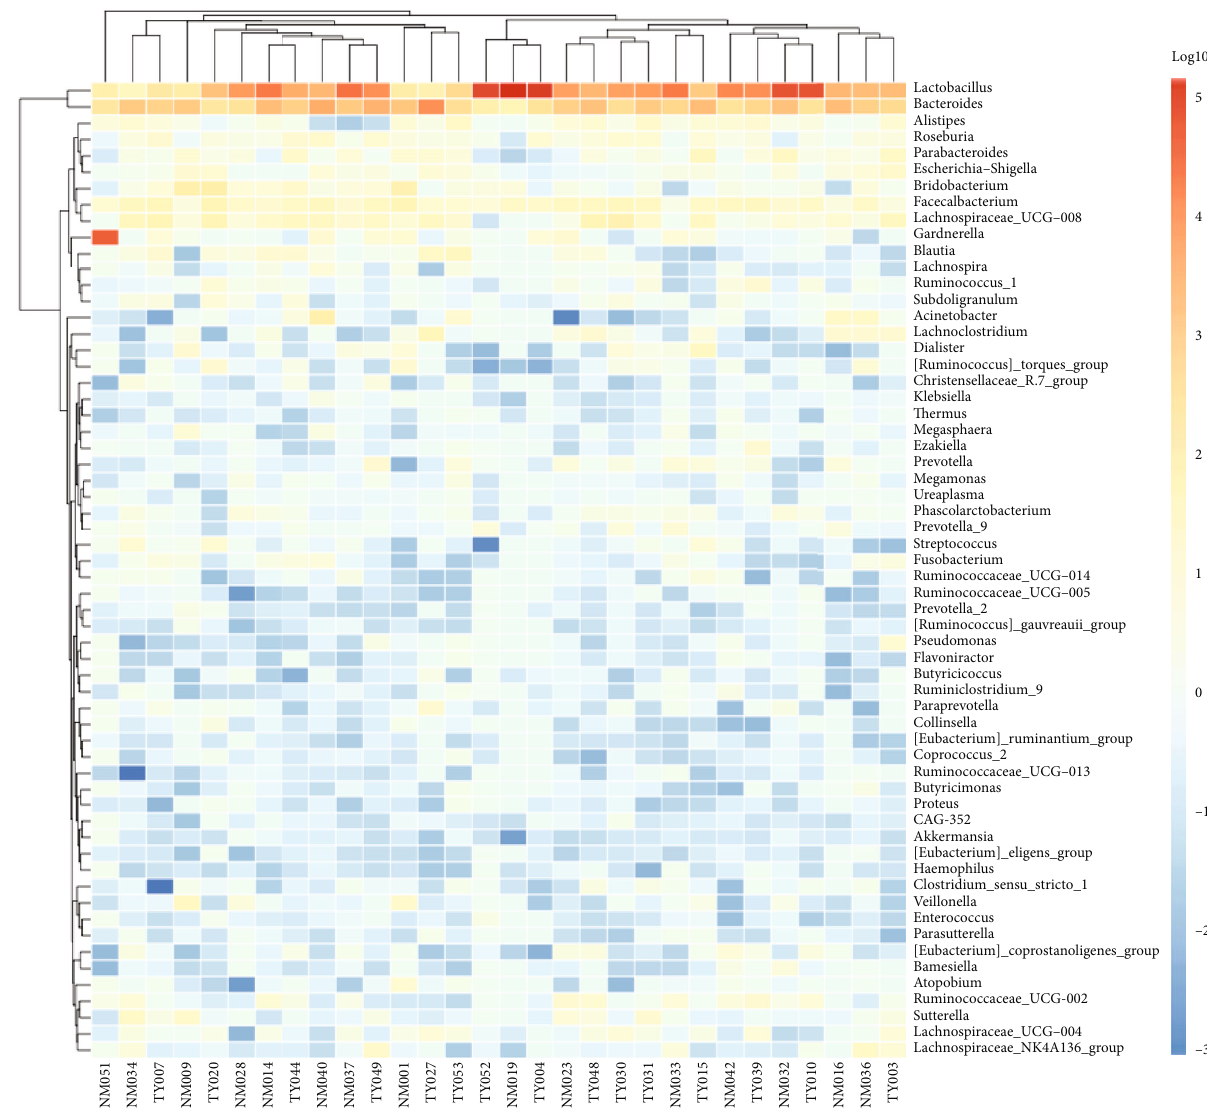
Figure 2: Heatmap clustering for vaginal microbiota at the genus level. Top 100 representative 16 s rRNA gene-based bacterial sequences classi fi ed at the genus level. Red indicates higher abundance, while green and blue represent progressively decreasing